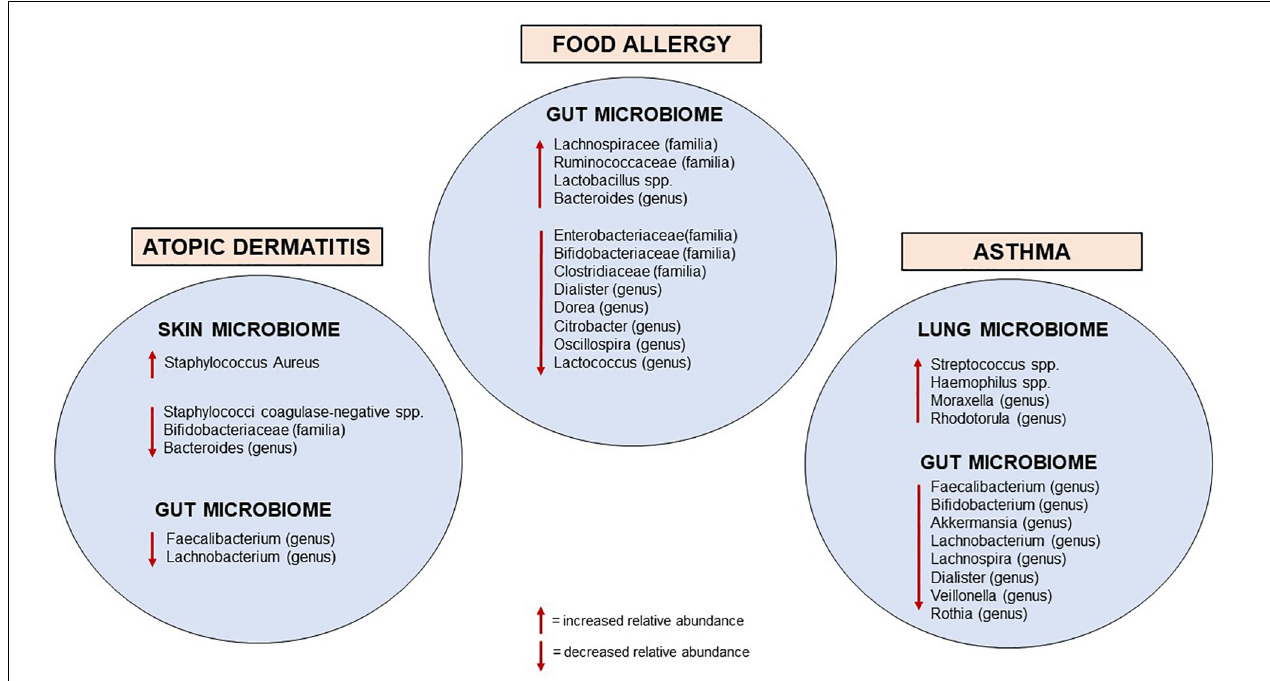
FIGURE 2 | Currently known microbiome perturbations in infancy associated with allergic